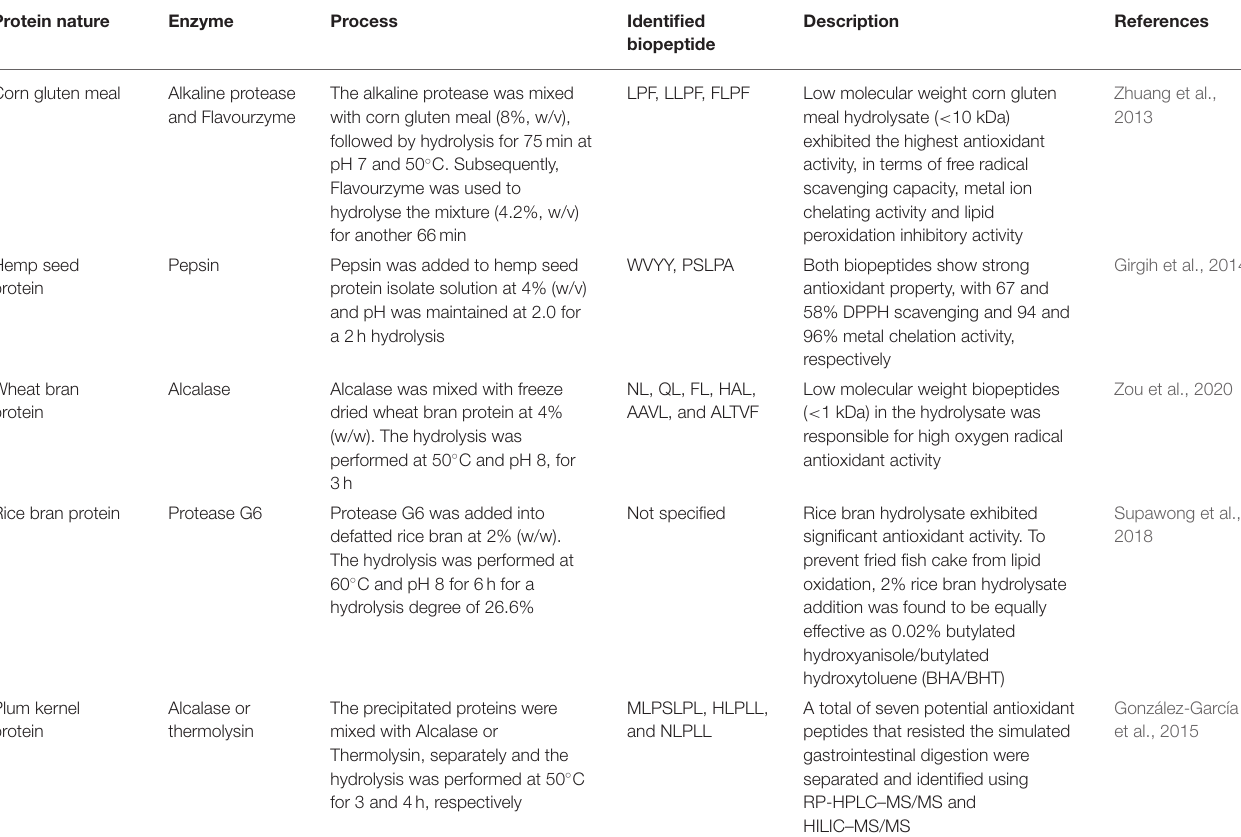
TABLE 2 | Some plant-based biopeptides with antioxidant activity. Protein